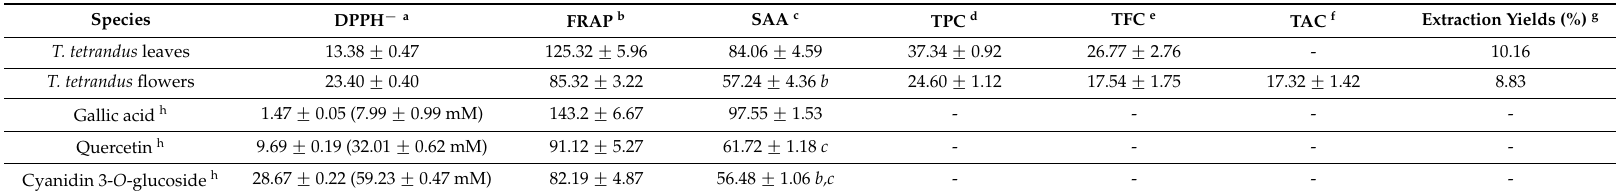
Table 1. Scavenging of the 1,1-diphenyl-2-picrylhydrazyl Radical (DPPH), Ferric Reducing Antioxidant Power (FRAP), Superoxide Anion scavenging activity (SAA), Total Phenolic Content (TPC), Total Flavonoid Content (TFC), Total Anthocyanin Content (TAC), and Extraction Yields of a mistletoe from the VIII Region of